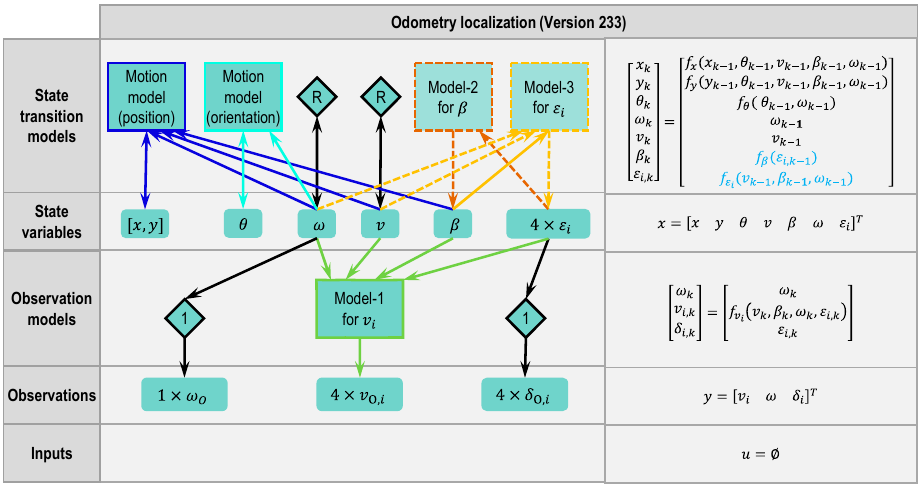
Figure 13. Modular approach to designing a state estimator for odometry localization (Version 233 based on Version 212, changes marked with dashed lines or dashed blocks and blue letters, respec- tively).